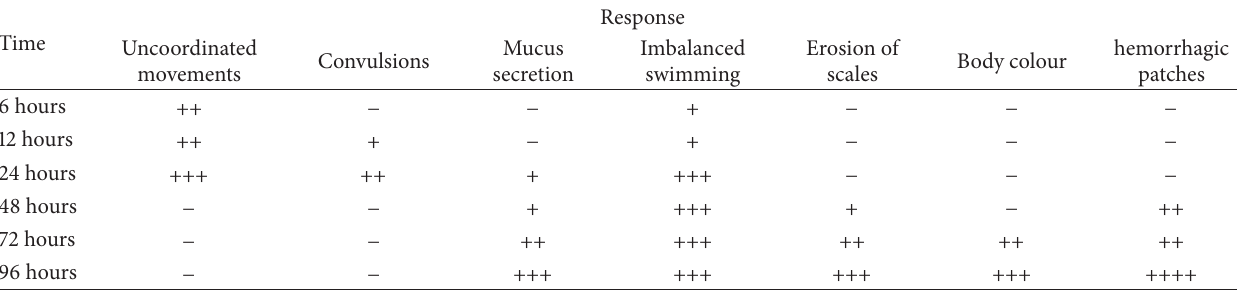
Table 3: Behavioural responses elicited by common carp during